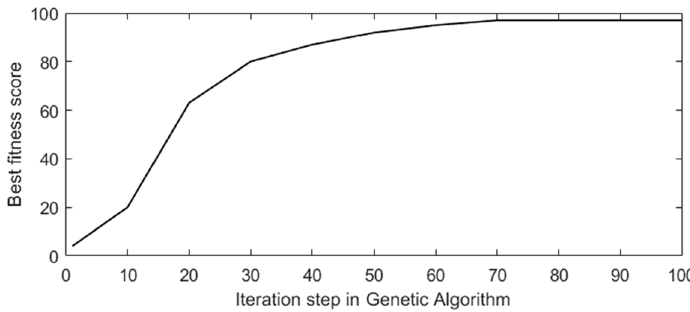
Figure 14. Best fi tness score evolution throughout multiple generations.